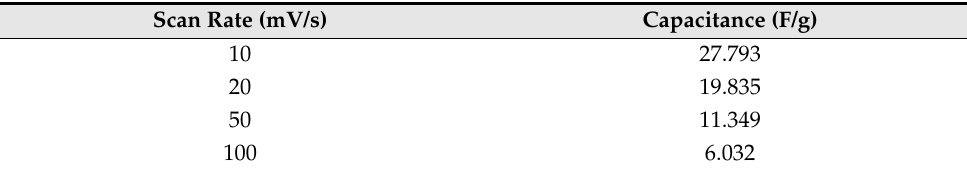
Figure 7. Variation in cyclic voltammetry (CV) plot shapes with changing the scan rate for the fabricated electrical double-layer capacitor (EDLC). Table 3. Variation in capacitance values with respect to different scan rates.